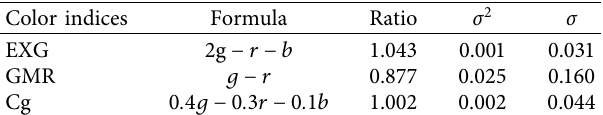
Figure 8: The effect of extraction methods on the unoptimized OTSU algorithm. (a) and (b) Results of the corn green area extraction image. (c) and (d) Results of the weed green area extraction image. Table 1: The comparison results of the three measurement indi- cators on the extraction